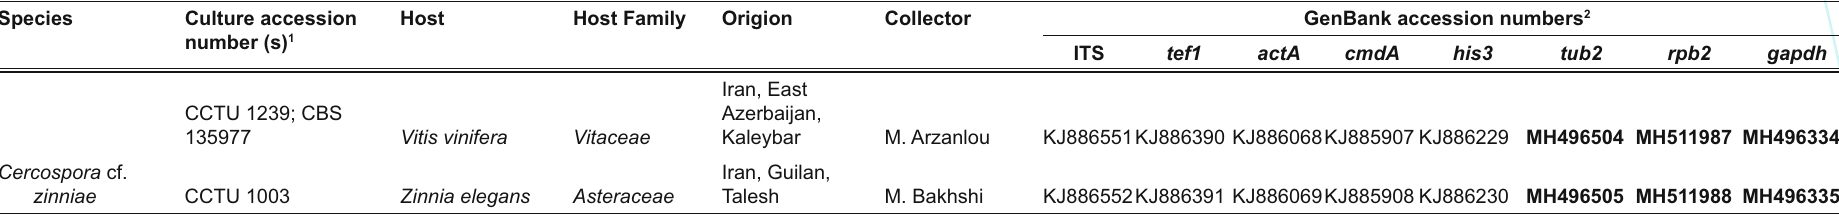
Table 1. (cid:24)%(cid:4)(cid:17)(cid:8)(cid:11)(cid:17)(cid:5)(cid:13)(cid:21)(cid:27)(cid:28) Species